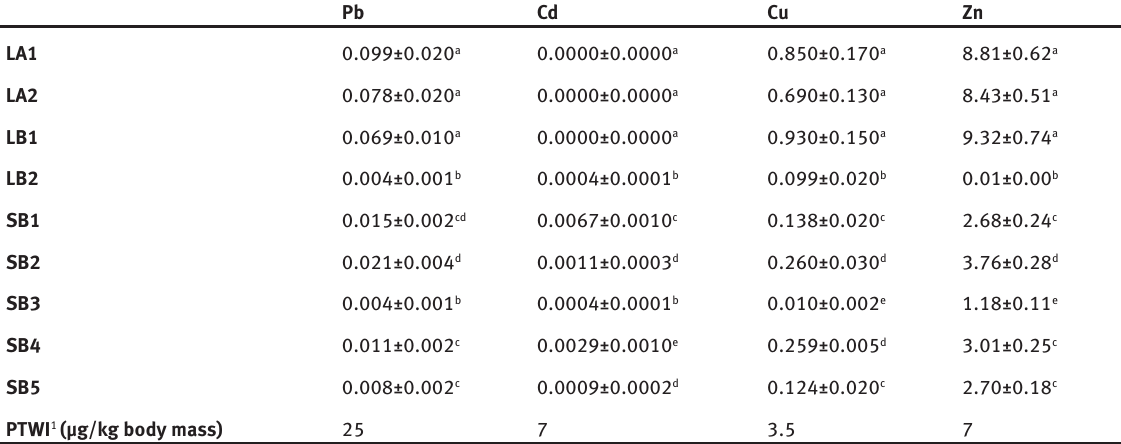
Table 5: Content of lead, cadmium, copper and zinc [mg/kg product] in yoghurt from various regions of Poland. Pb